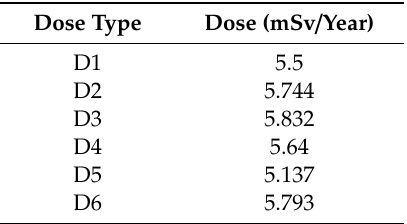
Table 9. The resultant doses of priority 1 parameters were determined by deterministic analysis and probabilistic